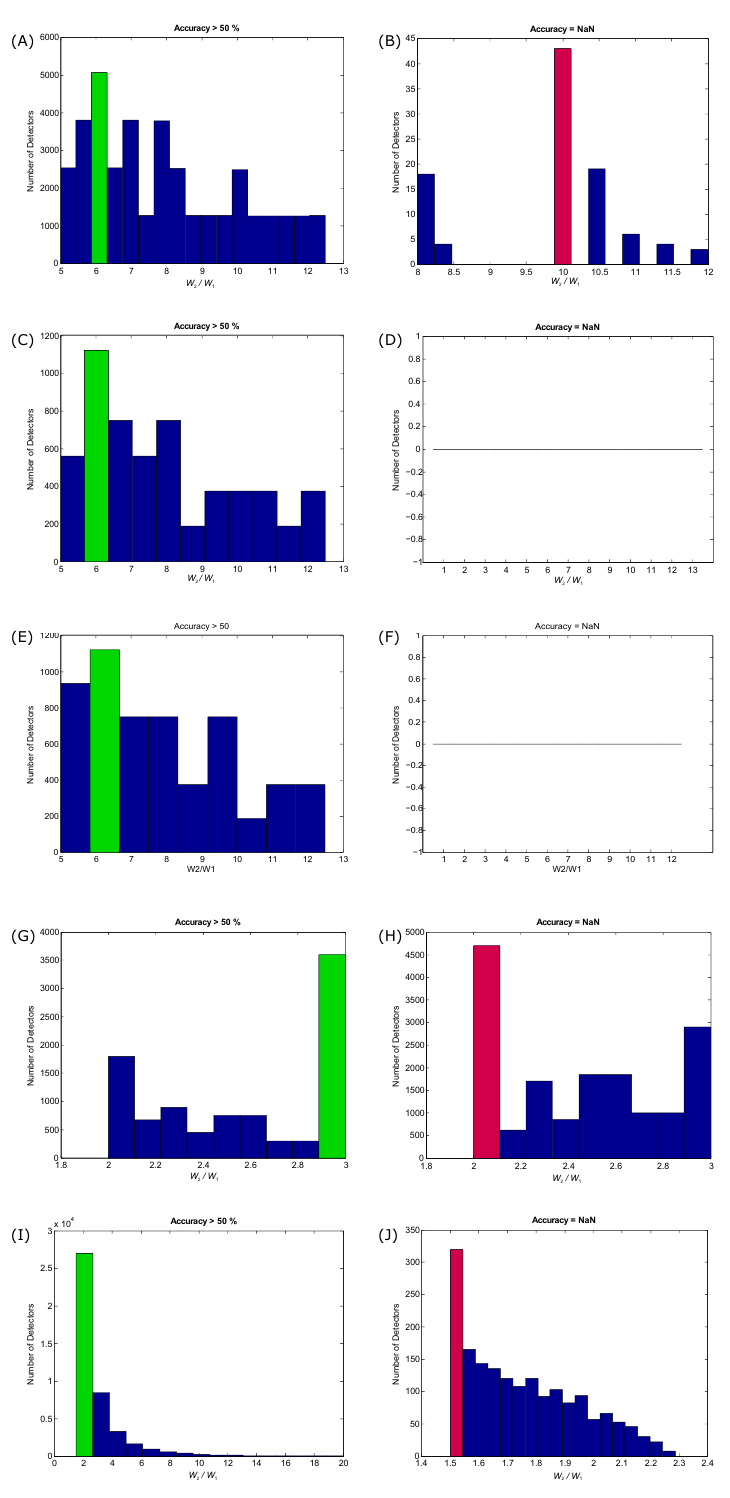
Figure 5. Influence of window sizes on the generation of blocks of interest based on overall accuracy. ( A , B ) QRS detection; ( C , D ) systolic waves detection; ( E , F ) a waves detection; ( G , H ) c , d , and e wave detection; ( I , J ) heart sound detection. The left column represents the coupling between the two moving averages by scoring >50% accuracy, while the right column represents non-coupling. The coupling is referred to as accuracy >50%, while non-coupling is referred to as not-a-number (NaN). The green bar represents the most dominant W 2 / W 1 ratio in coupling, while the red bar represents the most dominant W 2 / W 1 in